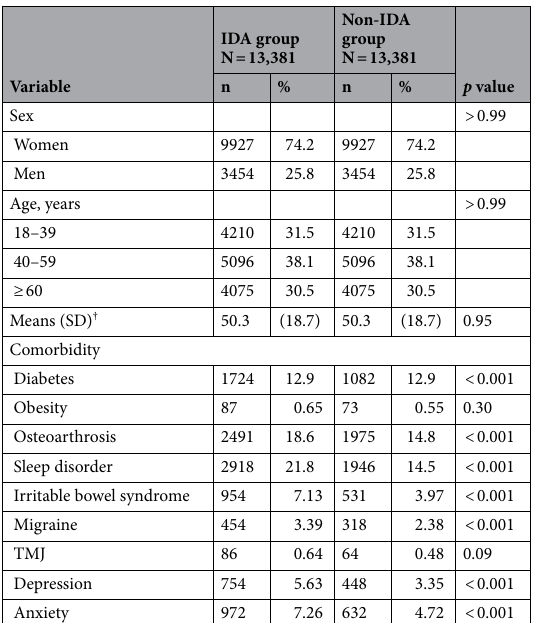
Table 1. Demographic factors and comorbidity of study participants according to iron deficiency anemia status. IDA iron deficiency anemia, SD standard deviation. † Student’s